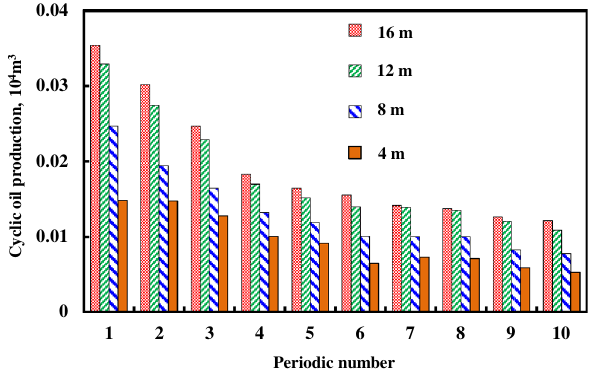
Fig. 5 Effect of distance from horizontal well to bottom water on cyclic oil